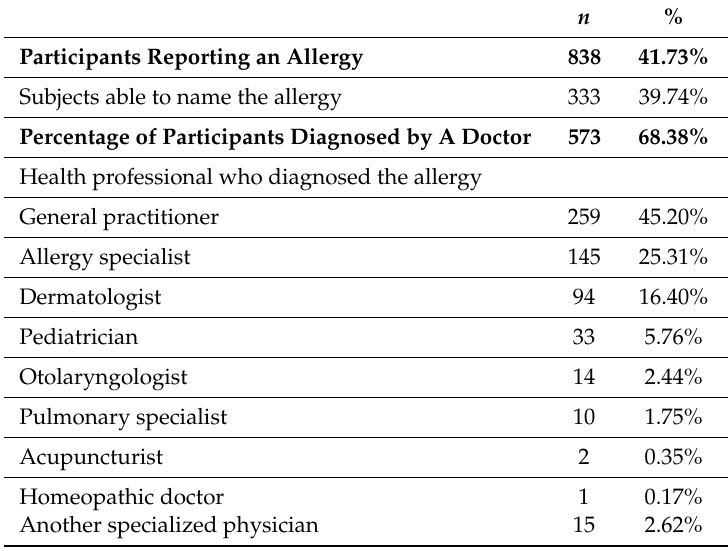
Table 2. Doctors who diagnosed